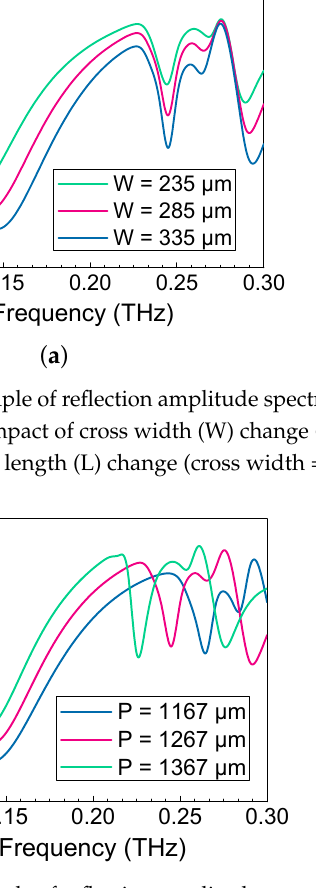
Figure 4. The example of reflection amplitude spectrum adjustment for Bi 88 Sb 12 films on a polyimide substrate due to a period (P) change (cross length = 915 µm and width = 285